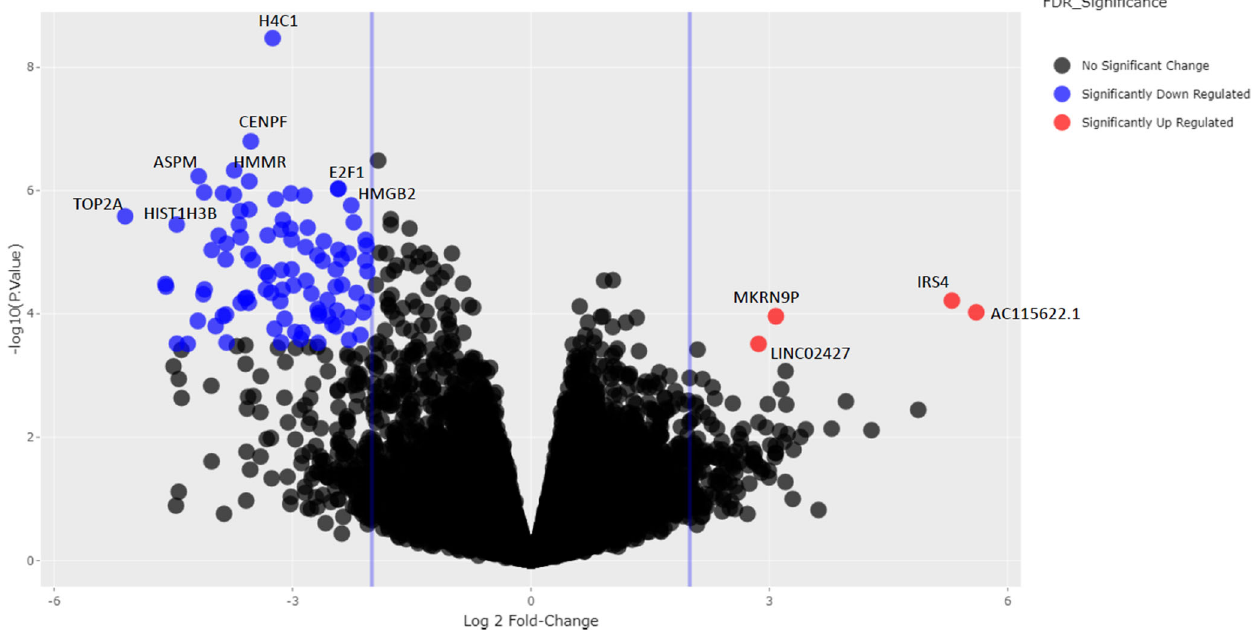
Fig. 5 Differentially expressed genes at C1D15 versus Baseline. The volcano plot color codes the genes that are statistically signi fi cant and have a log2 fold change of + 2 or − 2.